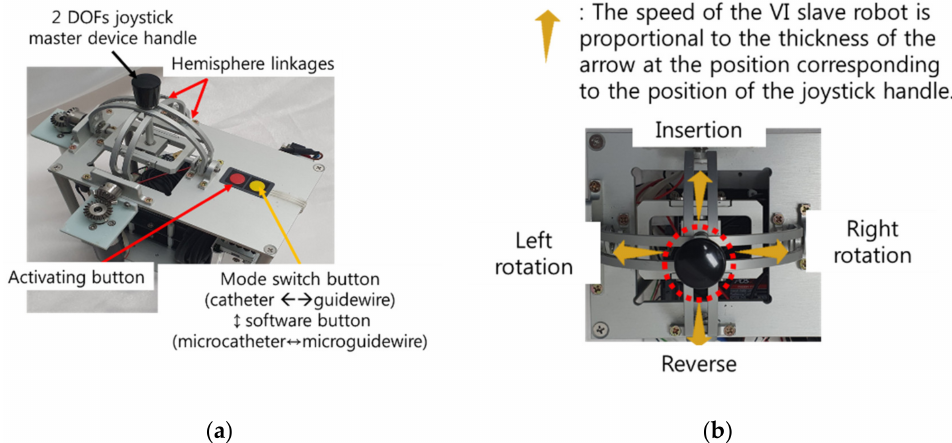
Figure 4. The 2 DOFs joystick-type master device: ( a ) Design of joystick-type master device and buttons; ( b ) Description of the position-velocity control method of the 2 DOFs joystick-type mas- ter